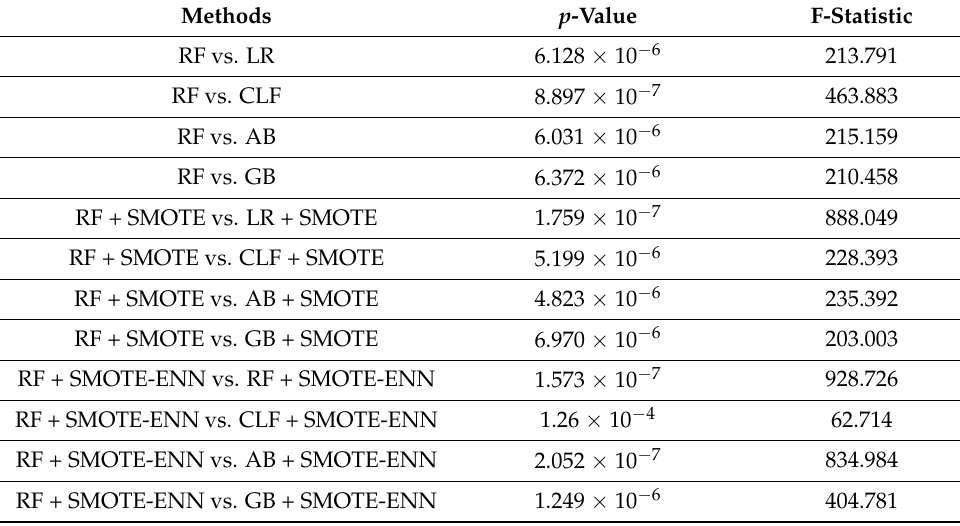
Table 6. Statistical significance of classifiers for hotel